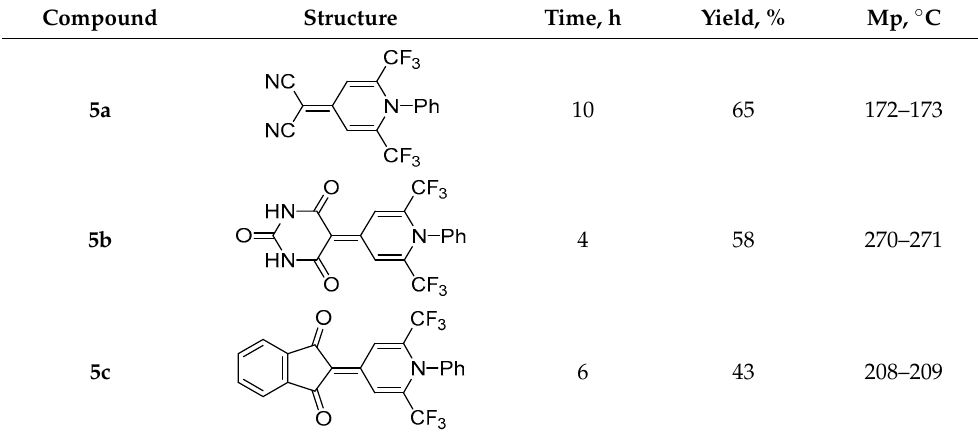
Table 3. Synthesis and structure of adducts 5a–c a .